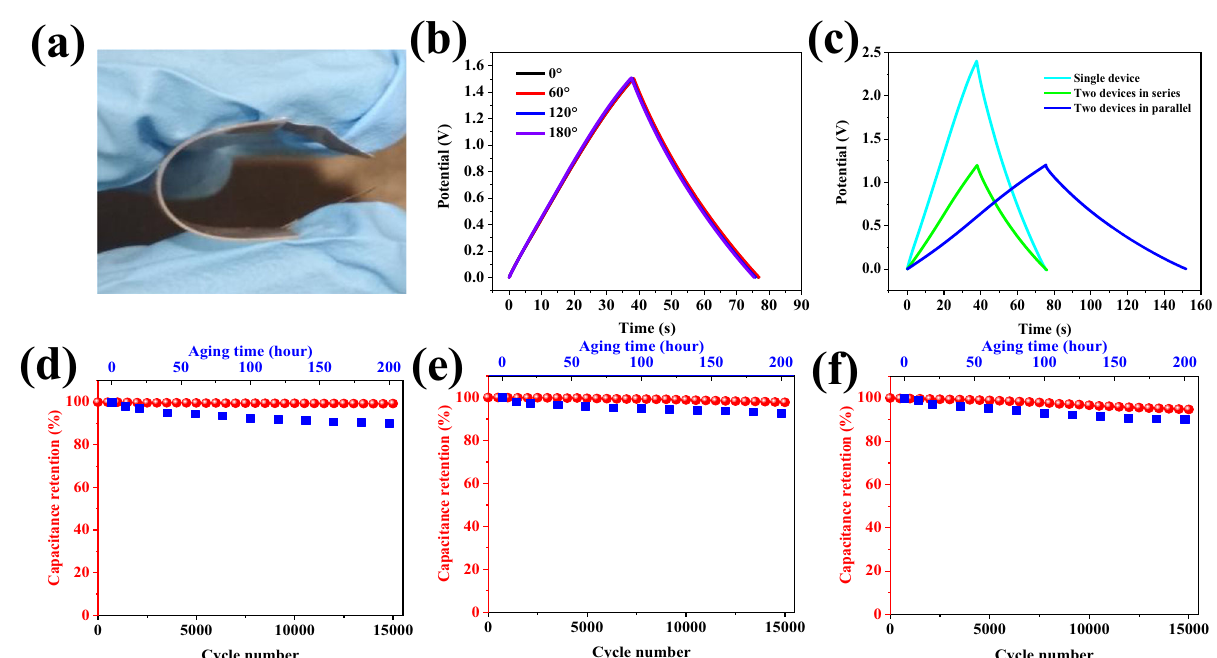
Fig. 5 Flexibility, output, durability, and cyclability evaluations of TFSCs. a Representative photograph of a fabricated TFSC under bending. b CC curves of MTB-4-based TFSCs under various bending angles from 0 ˚ to 180 ˚ at 0.1 mA cm − 2 . c CC curves of MTB-4-based TFSCs in series or in parallel connection at 0.1 mA cm − 2 . d – f Capacitance retention of MTB-4, MZB-4, and MIB-3 based TFSCs after 15,000 cycles at 0.05 mA cm − 2 (under 0 – 0.8 V voltage window) and 200 aging